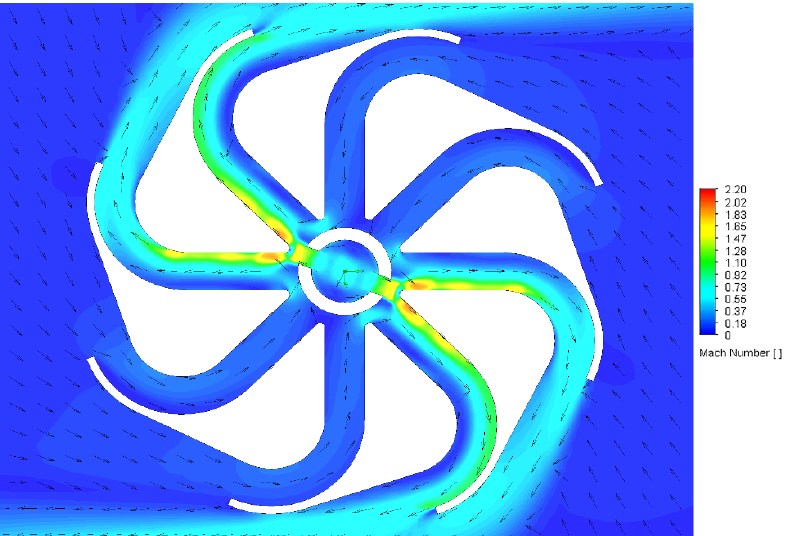
Figure 9. Computer simulation results for the turbine with a central nozzle diaphragm arrangement (Operation mode 2). Source: authors’ development.